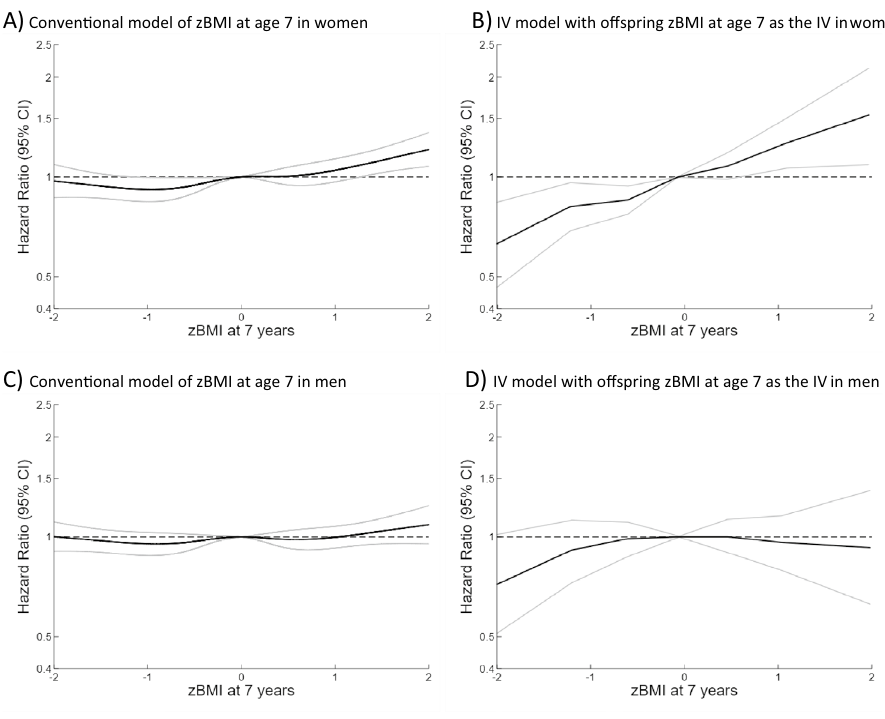
Figure 1. Association between zBMI at age 7 and all-cause mortality in men estimated by a conventional model and instrumental variable (IV) model. All models are adjusted for parental and offspring birth cohort, parental and offspring zheight.